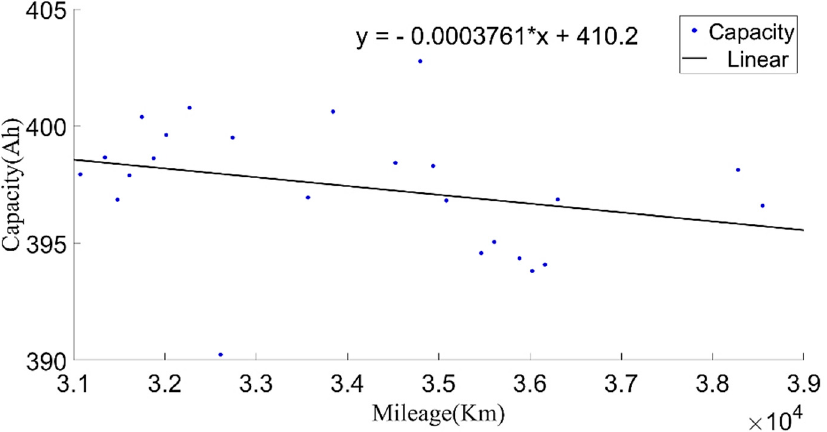
Figure 12. The relationship between the current capacity and the mileage at the charging temperature of 25 °C.